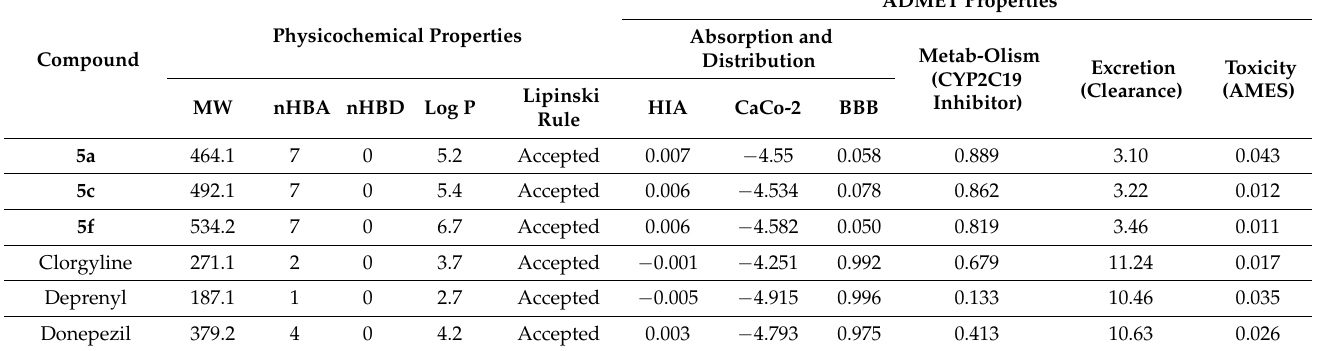
Table 2. Drug-like and ADMET characteristics of potent synthesized molecules and controls a .